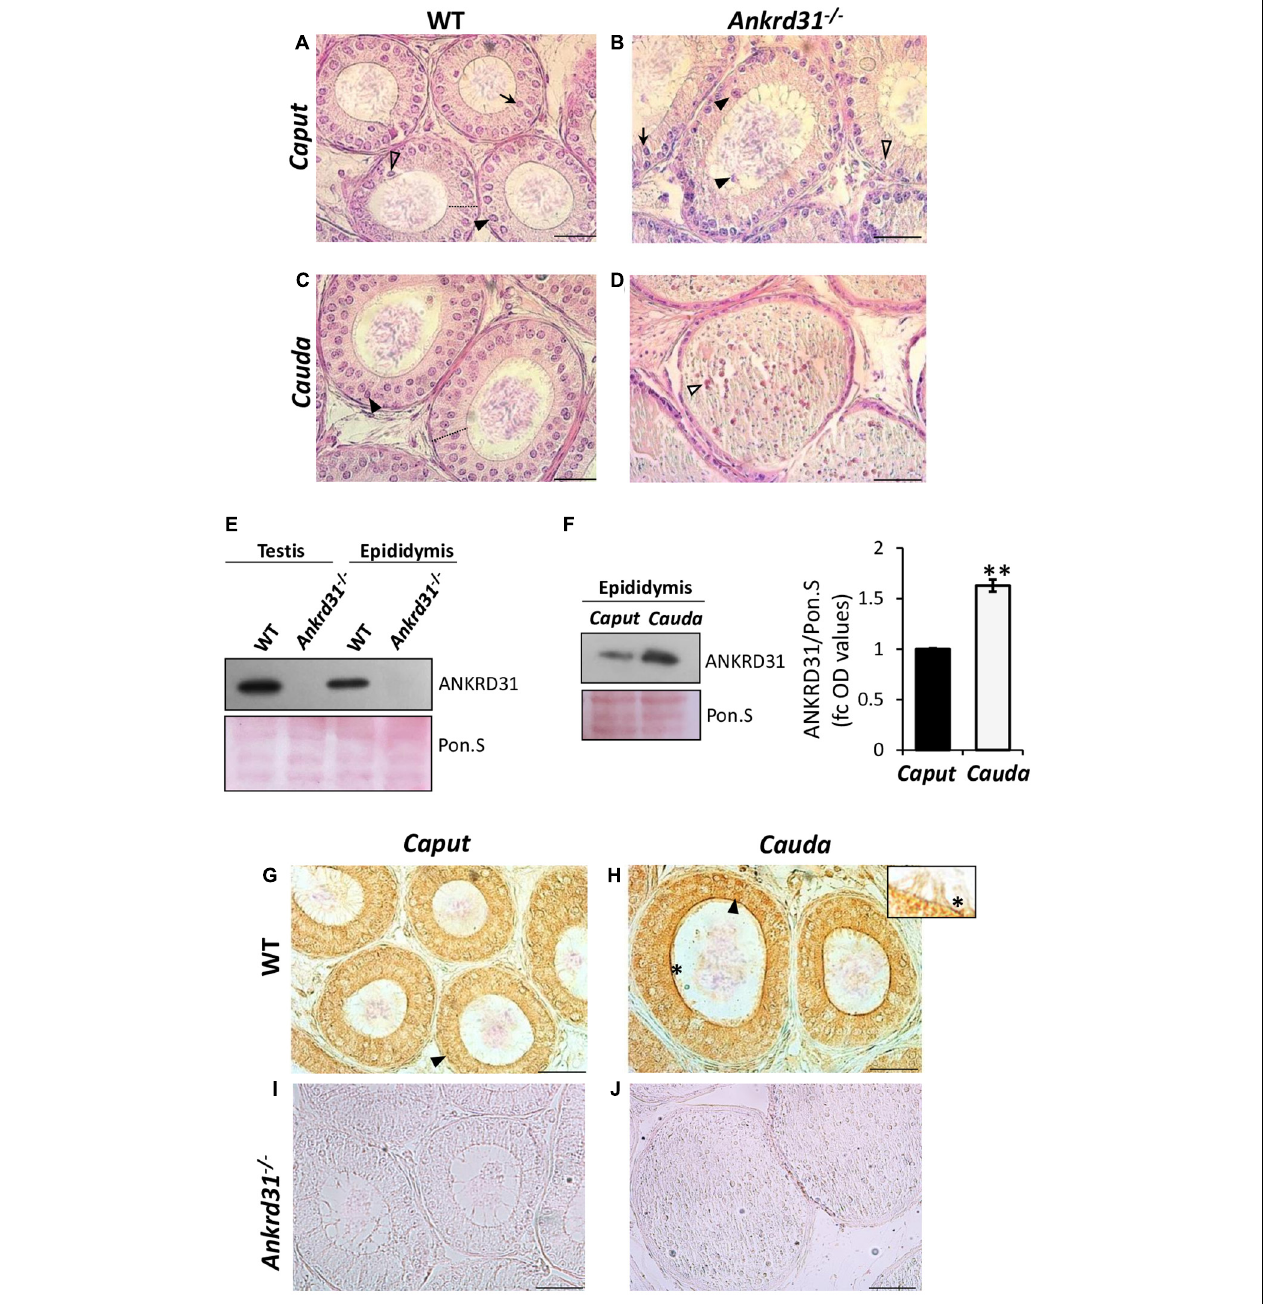
FIGURE 5 | (A–D) H&E staining of Bouin’s fixed WT and Ankrd31 − / − caput and cauda epididymis sections (7 µ m). Principal cells (PCs) are indicated by black arrowheads. Clear cells (CCs) are indicated by clear arrowheads. Narrow cells (NCs) are indicated by black arrows. Blood cell infiltration is indicated by white arrowheads. Columnar epithelium stratification was indicated by dashed lines. Scale bar corresponds to 50 µ m. (E) Western blot analysis of ANKRD31 in WT and Ankrd31 − / − testes and epididymides. (F) Western blot analysis of ANKRD31 in WT caput and cauda epididymides. Signals were quantified by densitometry analysis and normalized to Ponceau Red (Pon.S). Data are expressed in OD values as fold change and reported as mean ± SEM, ** p < 0.01. (G–J) Immunocytochemistry of ANKRD31 in Bouin’s fixed WT and Ankrd31 − / − caput and cauda epididymis sections (7 µ m). The ANKRD31 protein localization in PCs and stereocilia was indicated by black arrowheads and black asterisks, respectively. Scale bar corresponds to 50 µ m. No ANKRD31 signal was observed in Ankrd31 − / − caput and cauda epididymides.